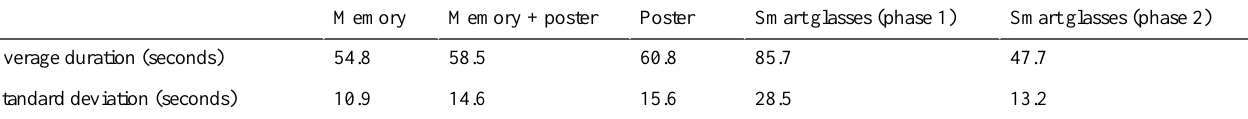
Smart glasses (phase 2)Smart glasses (phase 1)PosterMemory + posterMemory